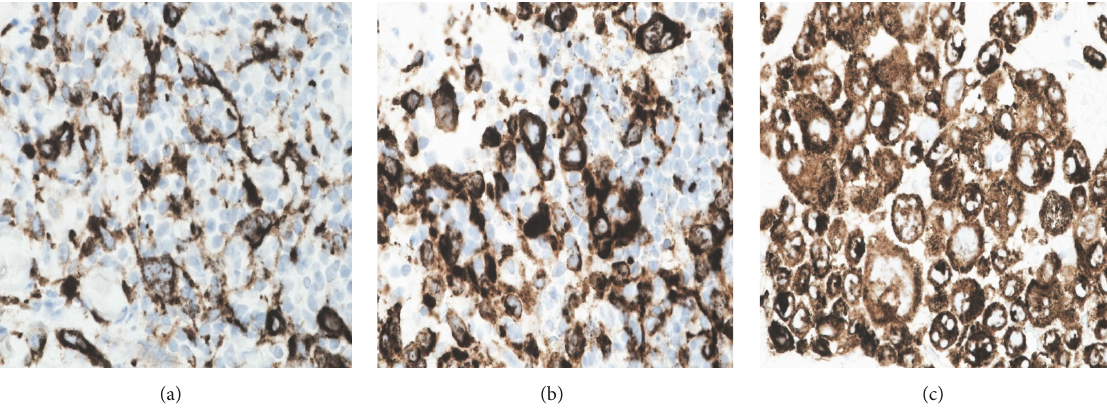
Figure 3: Langerin immunohistochemistry highlights tumour cells at the three biopsy sites (a), (b), and (c).